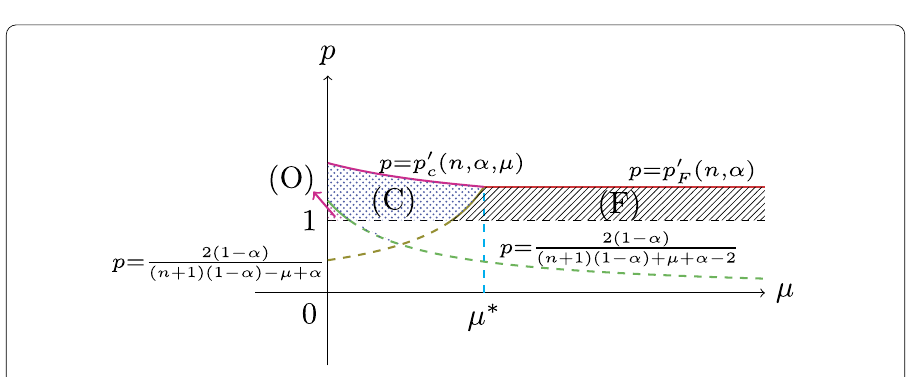
Figure 4 Range of blow-up conditions in case n = 3 and α =